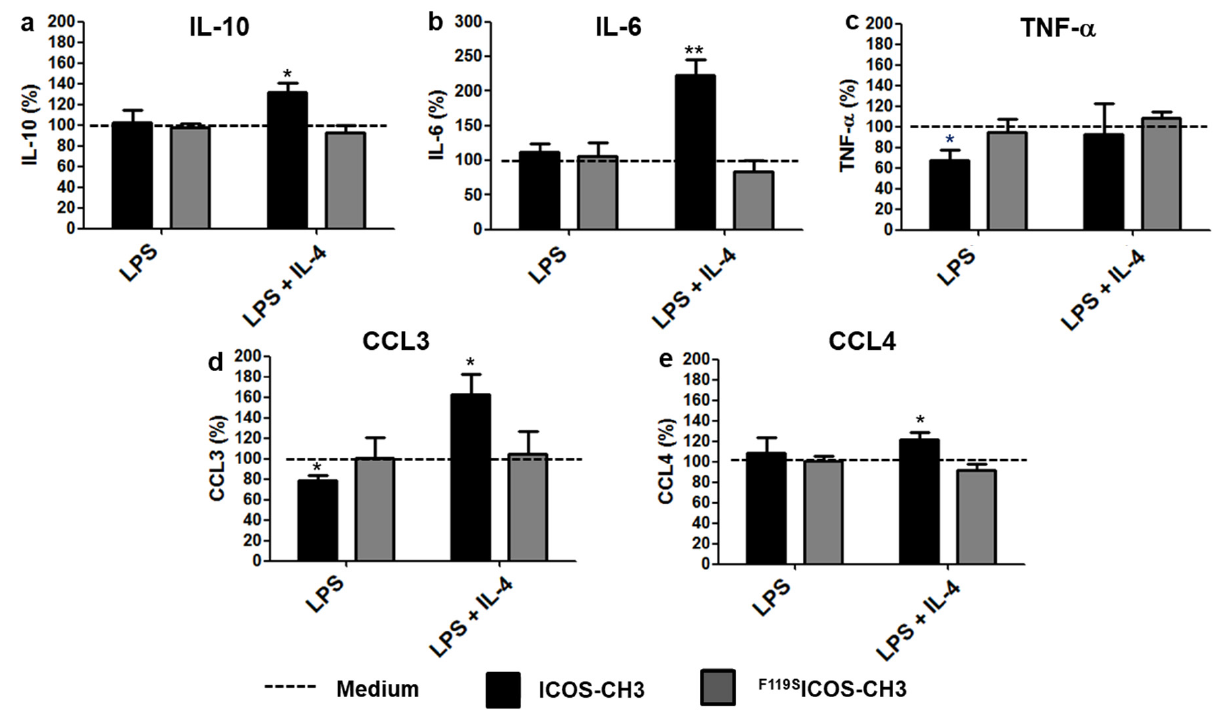
Figure 4. Effect of ICOS-CH3 on cytokine/chemokine secretion of M2 cells treated with different stimuli. M2 MDMs were cultured with DM + LPS in the presence or absence of IL-4 plus ICOS-CH3 or F119S ICOS-CH3. Culture supernatants were harvested after 2 d and examined for IL-10 ( a ), IL-6 ( b ), TNF- α ( c ), CCL3 ( d ), and CCL4 ( e ) production by ELISA. Data represent the mean and SEM expressed as a percentage of results from five/six independent experiments performed in triplicate. The corresponding samples cultured without ICOS-CH3 or F119S ICOS-CH3 were set at 100% (whose absolute data are shown in Figure S2). * p < 0.05, ** p < 0.01 vs. the corresponding 100%